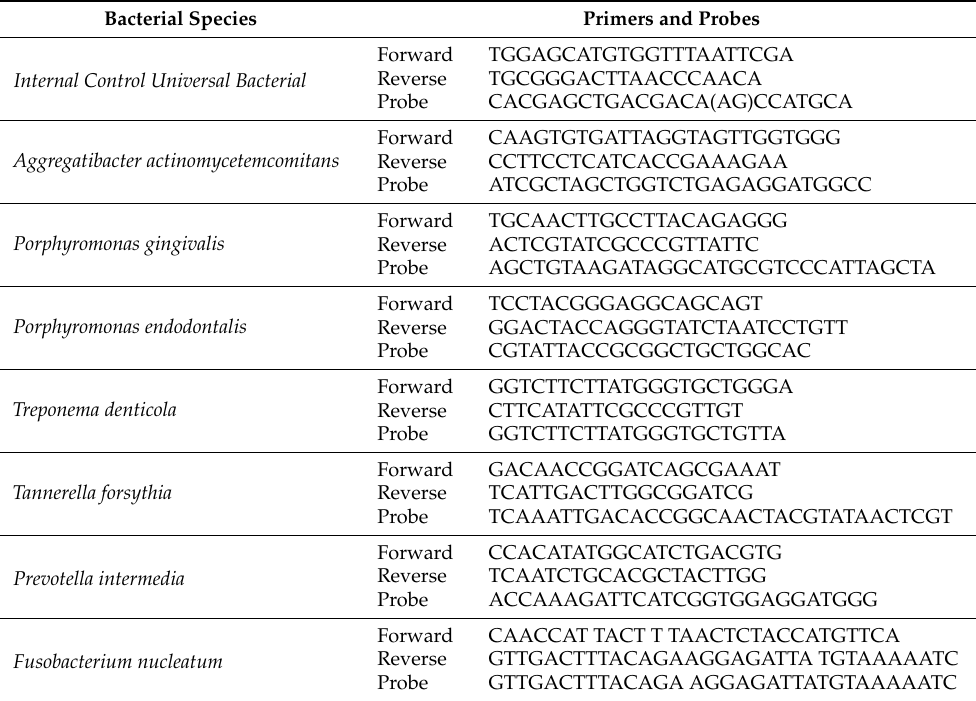
Table 1. Probe and primer sequences used for periodontal bacteria identification and quantization with real time